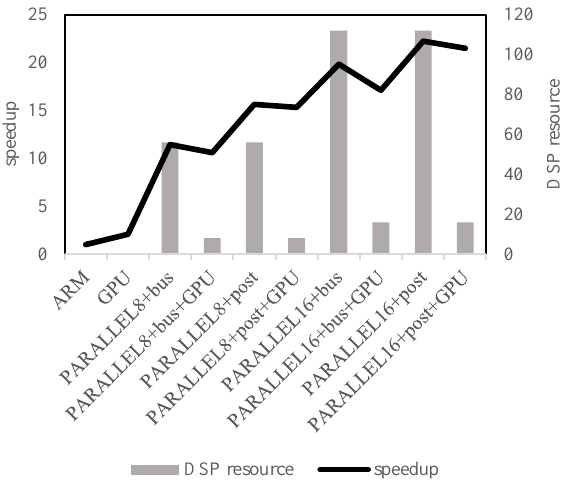
Figure 12. Speedup and DSP resource utilization of FPGA. The subscript numbers under ‘PARALLEL’ represent the parallelism of the FPGA computing units. The ‘bus’ and ‘post’ represent communication mechanisms between servants.